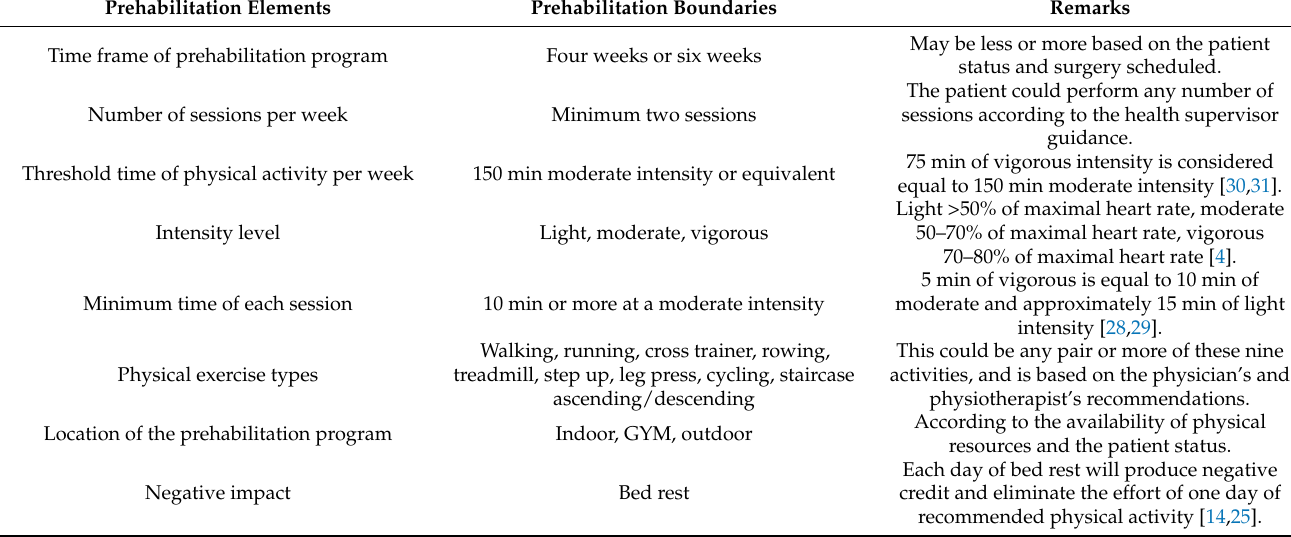
Table 2. Key prehabilitation elements, boundaries, and rules for the